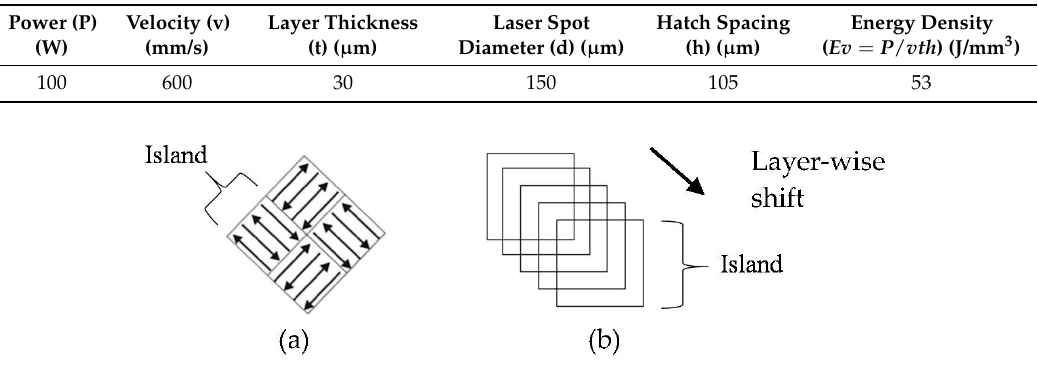
Figure 2. ( a ) island hatch strategy [22] and ( b ) island shift strategy.